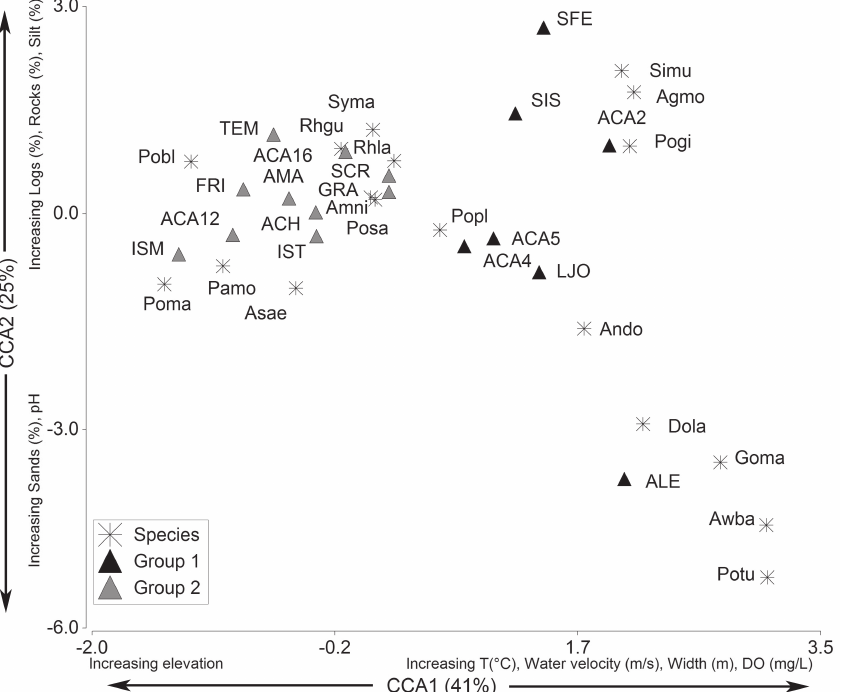
Fig. 4. Canonical Correspondence Analysis (CCA), showing 17 sites, 18 species and environmental variables of PC1 and PC2. Environmental variables used in axes had correlation coefficients ≥0.60 and statistical significance (p> 0.05). Two groups identified by species composition in the Río Acahuapa basin. Code of species: S. multipunctatus (Simu), A. monticola (Agmo), P. gillii (Pogi), P. pleurospilus (Popl), A. dowei (Ando), D. latifrons (Dola), G. maculatus (Goma), A. banana (Awba), P. turrubarensis (Potu), P. salvatoris (Posa), P. butleri (Pobu), A. nigrofasciata (Amni), A. aeneus (Asae), P. marcellinoi (Poma), S. marmoratus (Syma), R. guatemalensis (Raghu), R. laticauda (Rhla), P. motaguensi s